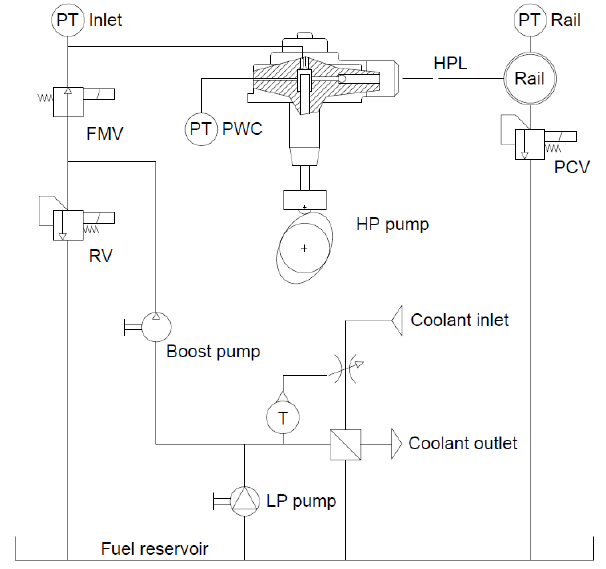
Figure 1. Schematic of experimental set-up.